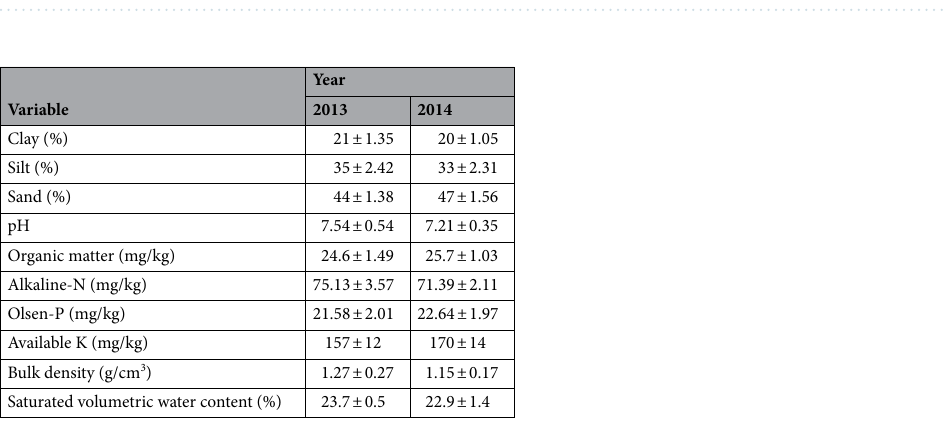
Table 2. Selected soil physical and chemical properties (0–60 cm depth) in the experiment